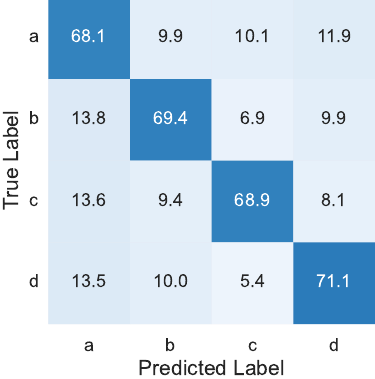
Figure 9. Confusion matrix of second step